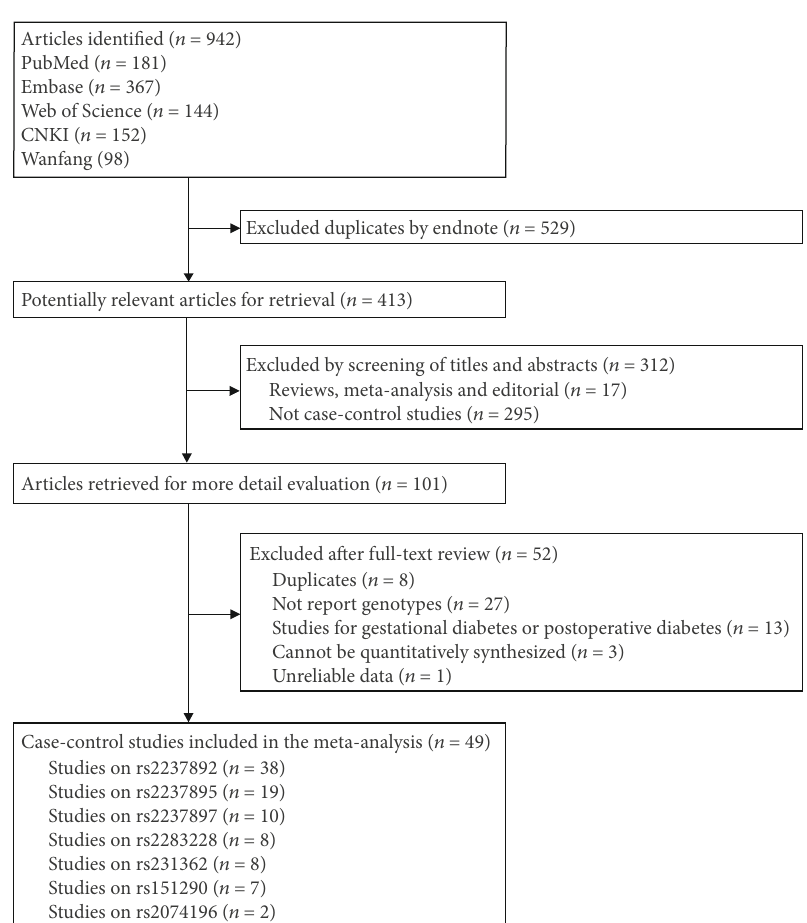
Figure 1: Flow diagram of the literature search and selection